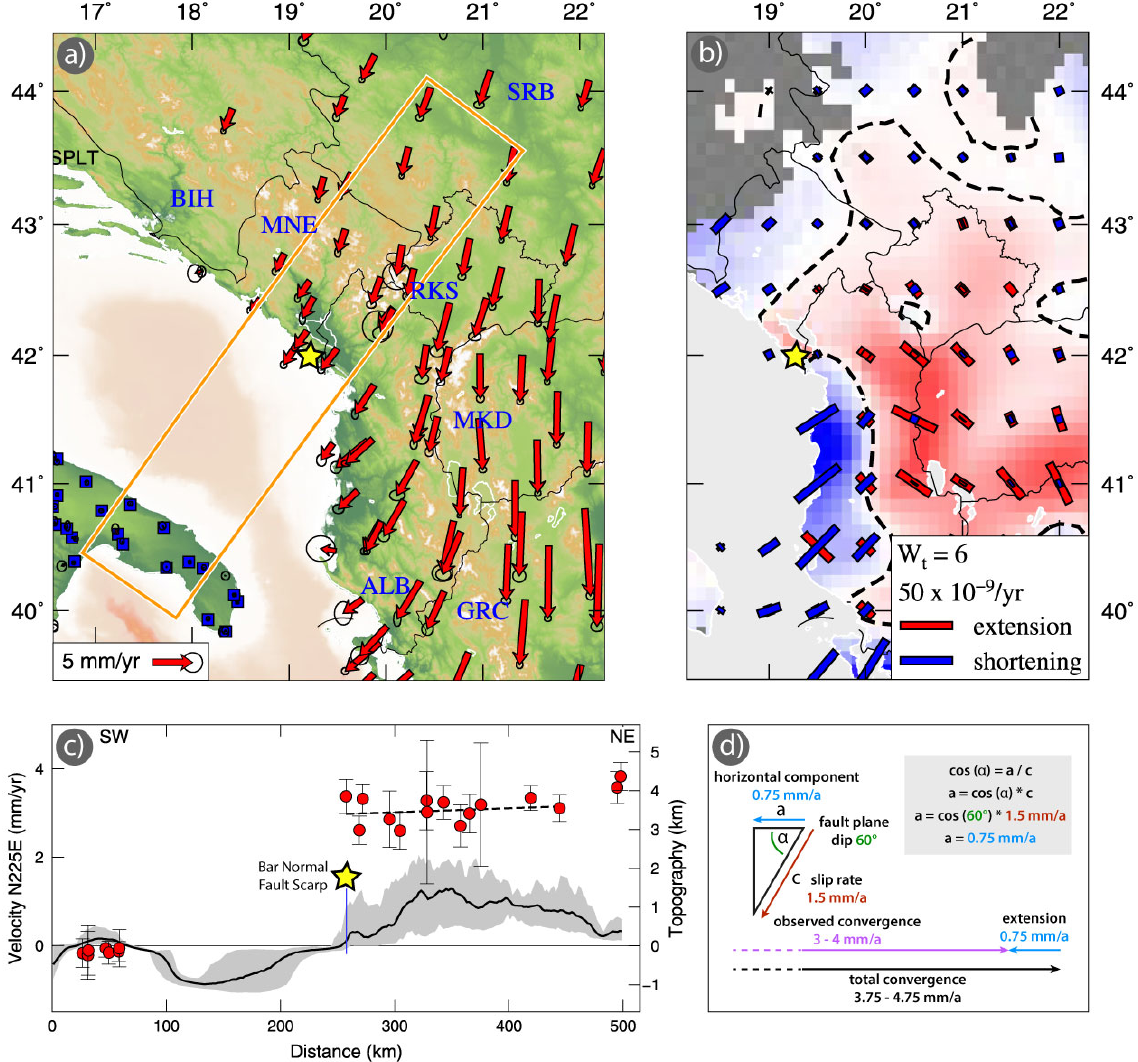
Figure 9. (a) Apulia referenced GPS velocity field and (b) interpolated strain rate with a Gaussian–Voronoi cell weighting of a net reweighting threshold of W t = 6 in the southwestern Balkans. (c) Swath topographic section with GPS velocity information through the working area. Panels (a) – (c) are modified after and reprinted with permission from D’Agostino et al. (2020); see their work for details. (d) Normal-faulting- related horizontal velocity component and its accelerating role in cross-regional